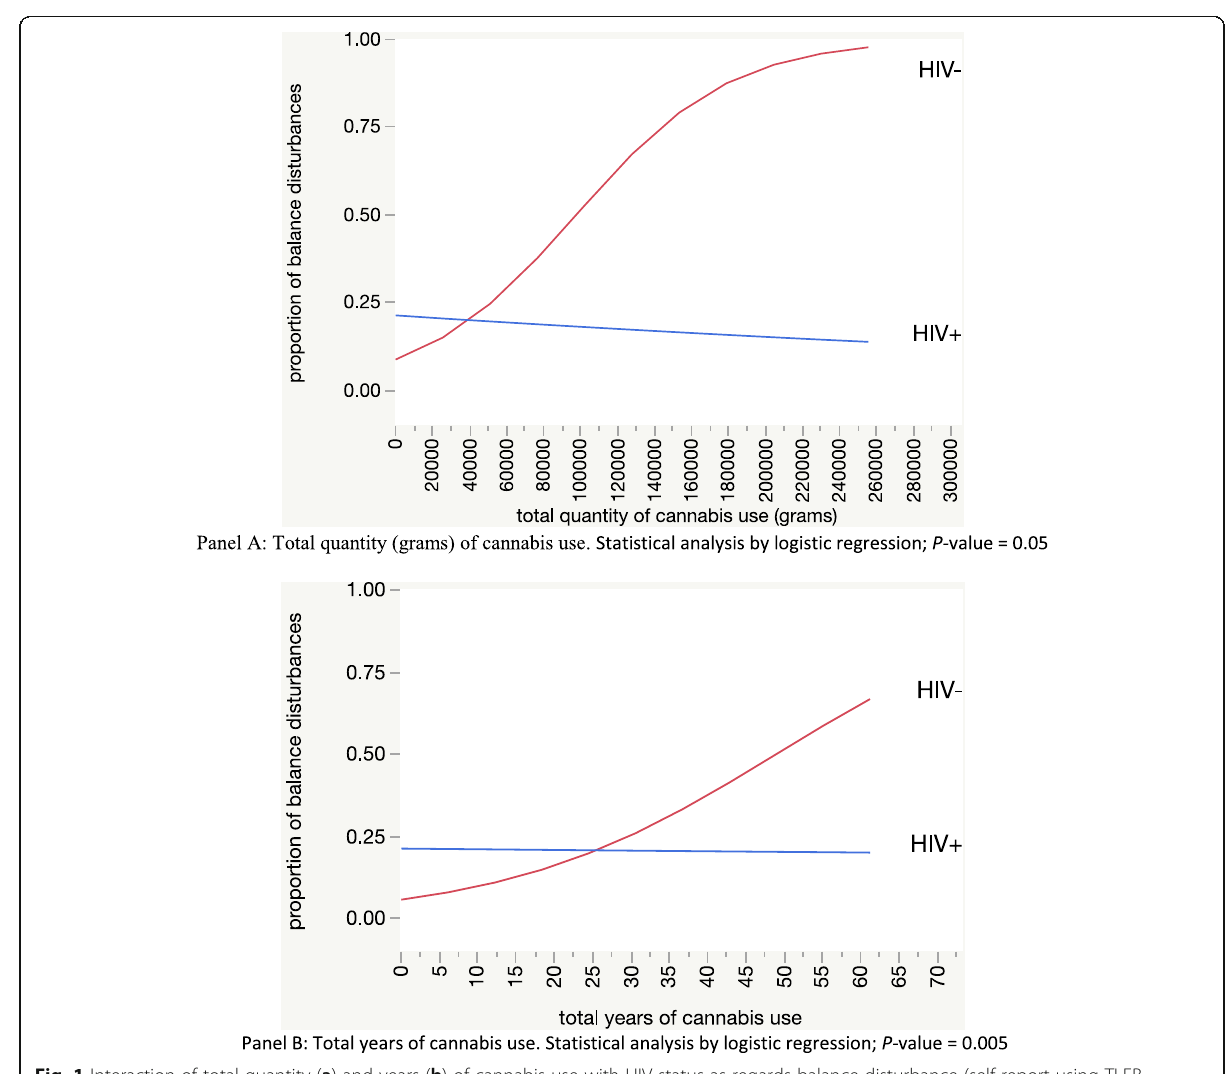
Fig. 1 Interaction of total quantity ( a ) and years ( b ) of cannabis use with HIV status as regards balance disturbance (self-report using TLFB method for cannabis variable; structured interview for balance